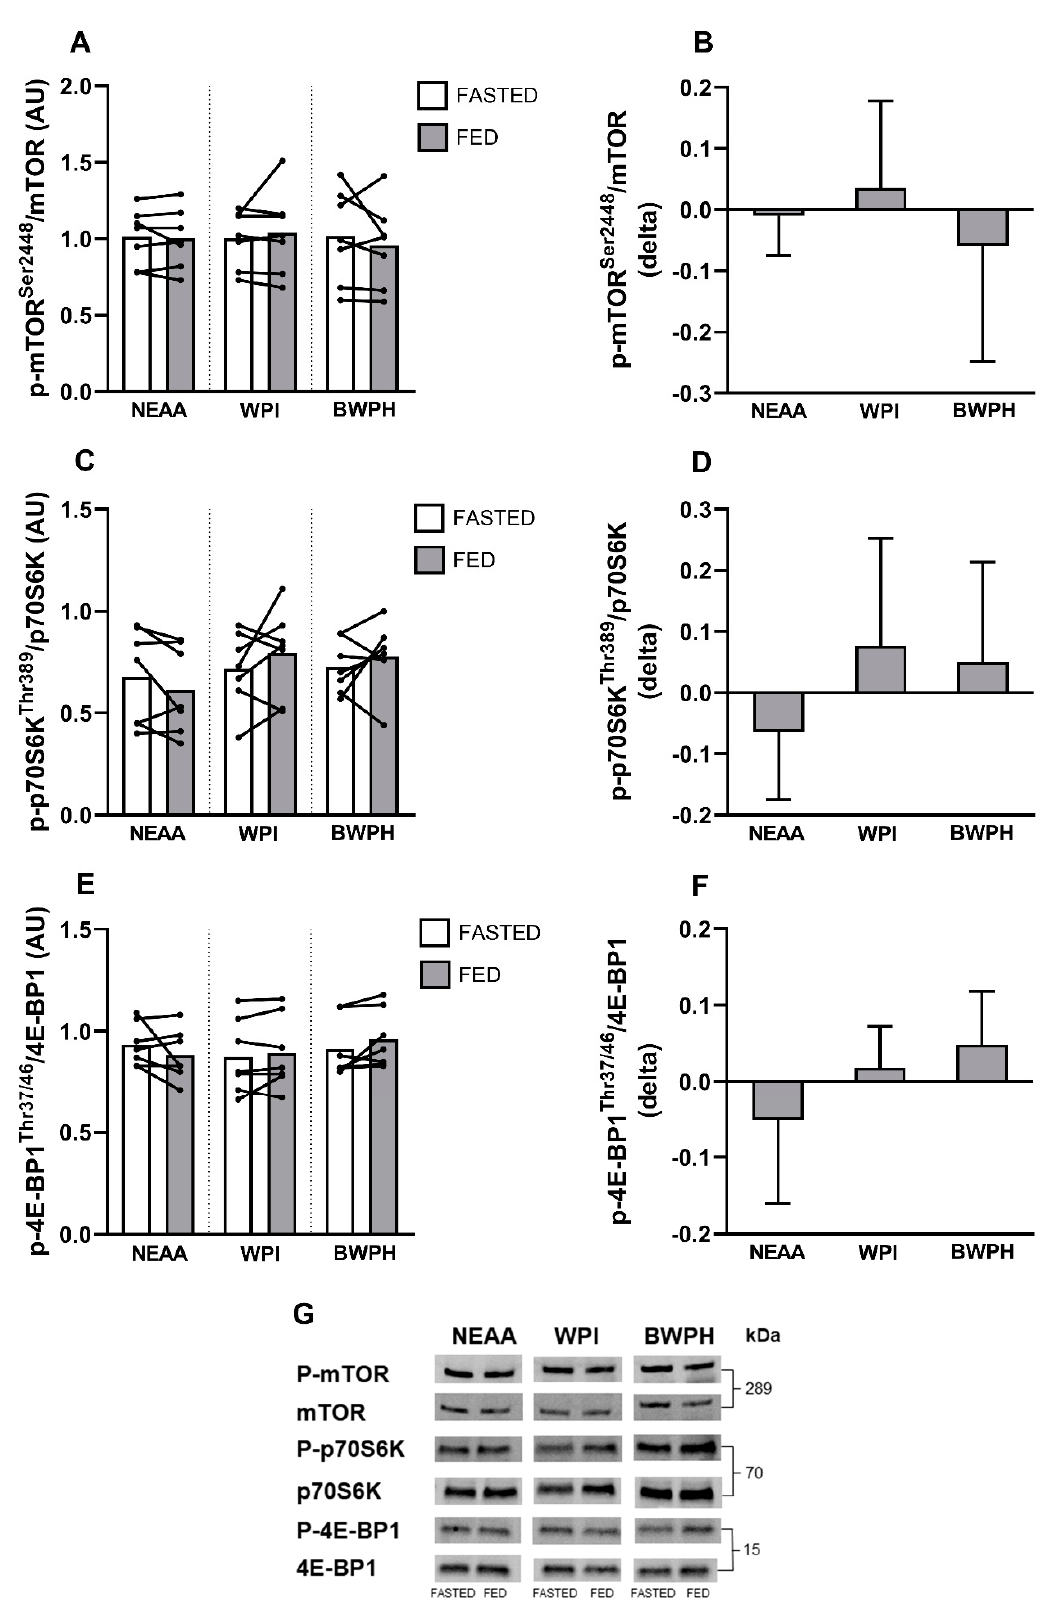
Figure 2. Phosphorylation of mTOR Ser2448 ( A ), p70S6K Thr389 ( C ), and 4E-BP1 Thr37/46 ( E ) in response to 1 h incubation with FASTED or FED (NEAA, WPI, and BWPH) human-conditioned serum. Densitometric analyses are reported in absolute terms (arbitrary units, AU) and difference scores (delta; ( B , D , F ), respectively). ( G ) Representative immunoblots for each total and